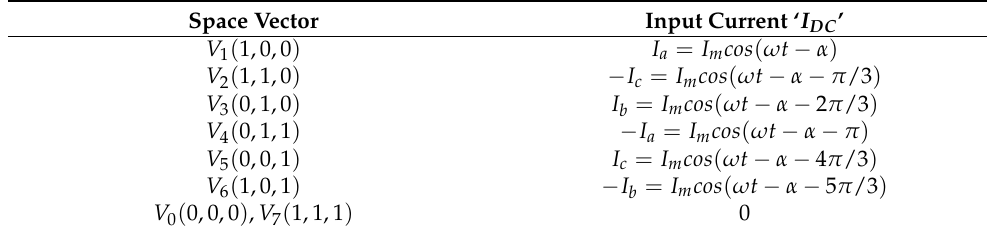
Table 2. DC input current in terms of output phase currents.